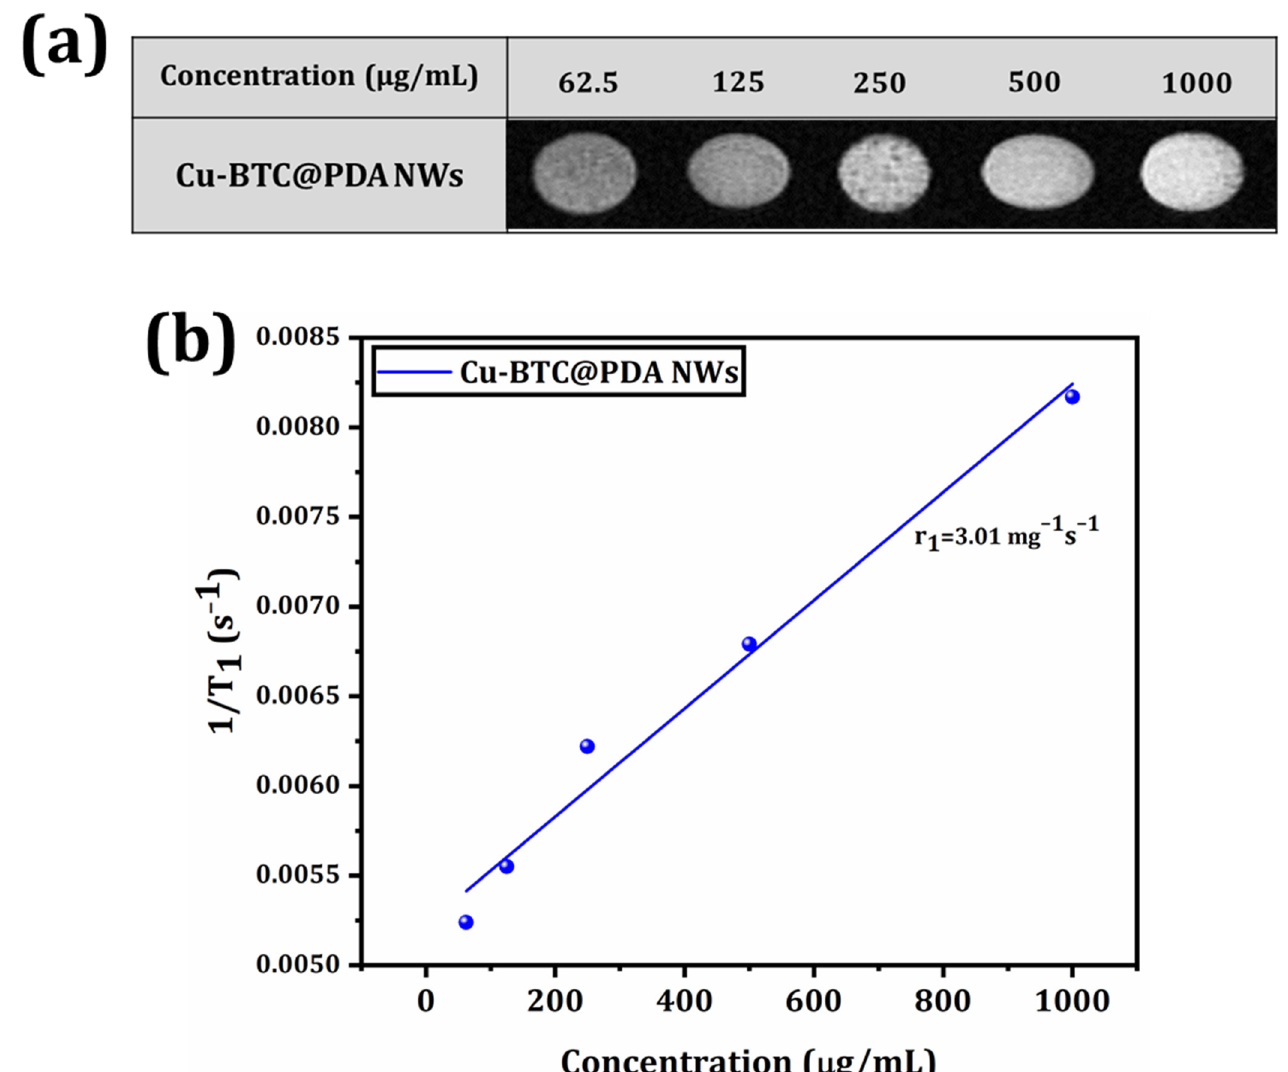
Figure 5. ( a ) In vitro T 1 weighted MRI images of Cu-BTC@PDA NWs. ( b ) 1/T 1 signal intensity of Cu- BTC@PDA